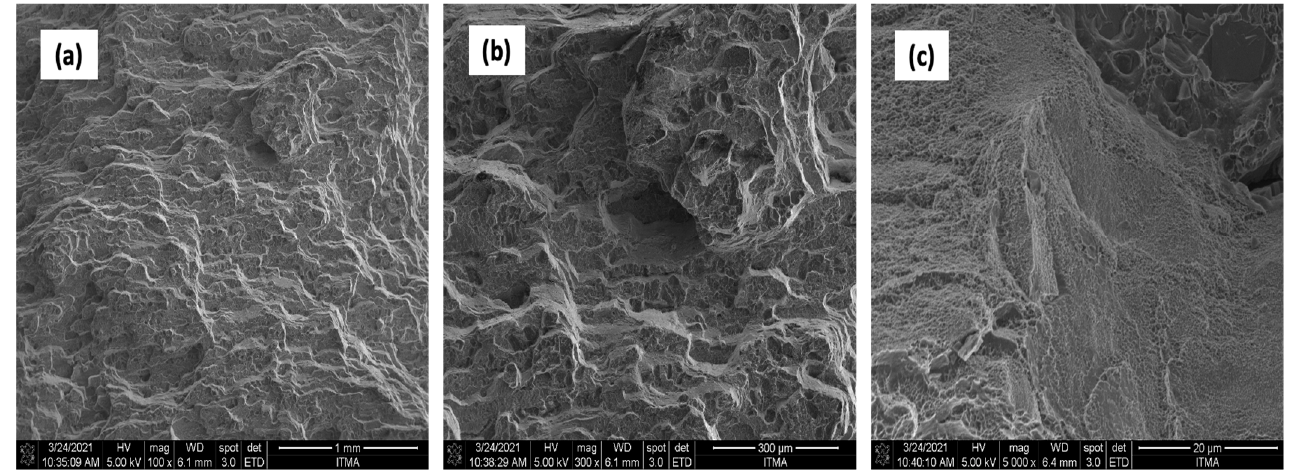
Figure 16. AA7075 AS ( a ) 100× ( b ) 300× ( c ) 5000×.